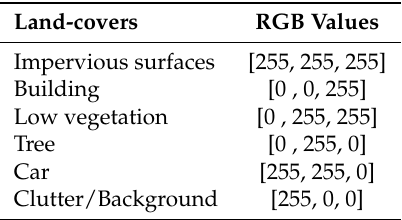
Figure 1. Example of Vaihingen 2D semantic labeling dataset. ( a ) true orthophoto, ( b ) annotated ground truth, and ( c ) legend. The ground truth contains six types of land-covers. Table 1. Reference of color map of Vaihingen